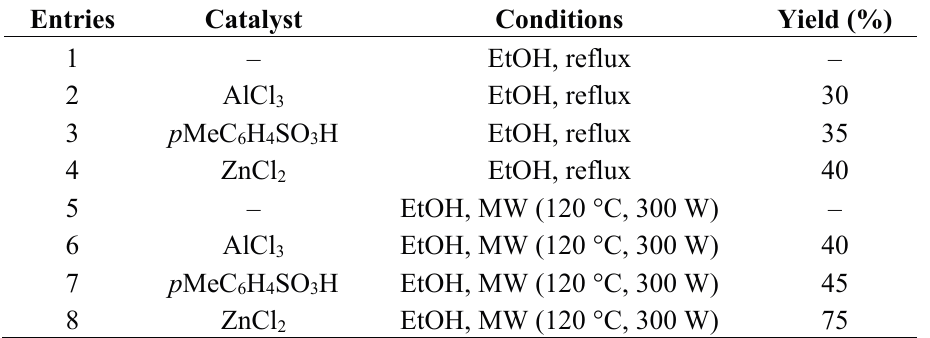
Table 1. Optimization of reaction conditions for the synthesis of compounds 3d .